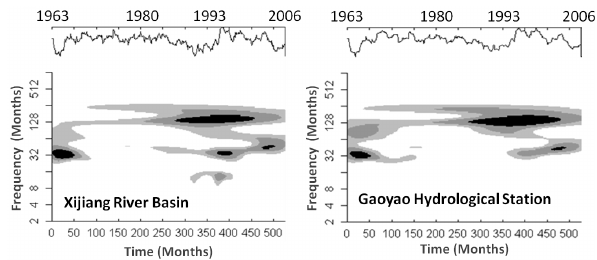
Fig. 11. Wavelet analysis of the SPI-24 (left panel) and the SDI- 24 (right panel) showing the low (grey) to high (black) significant amplitudes of the